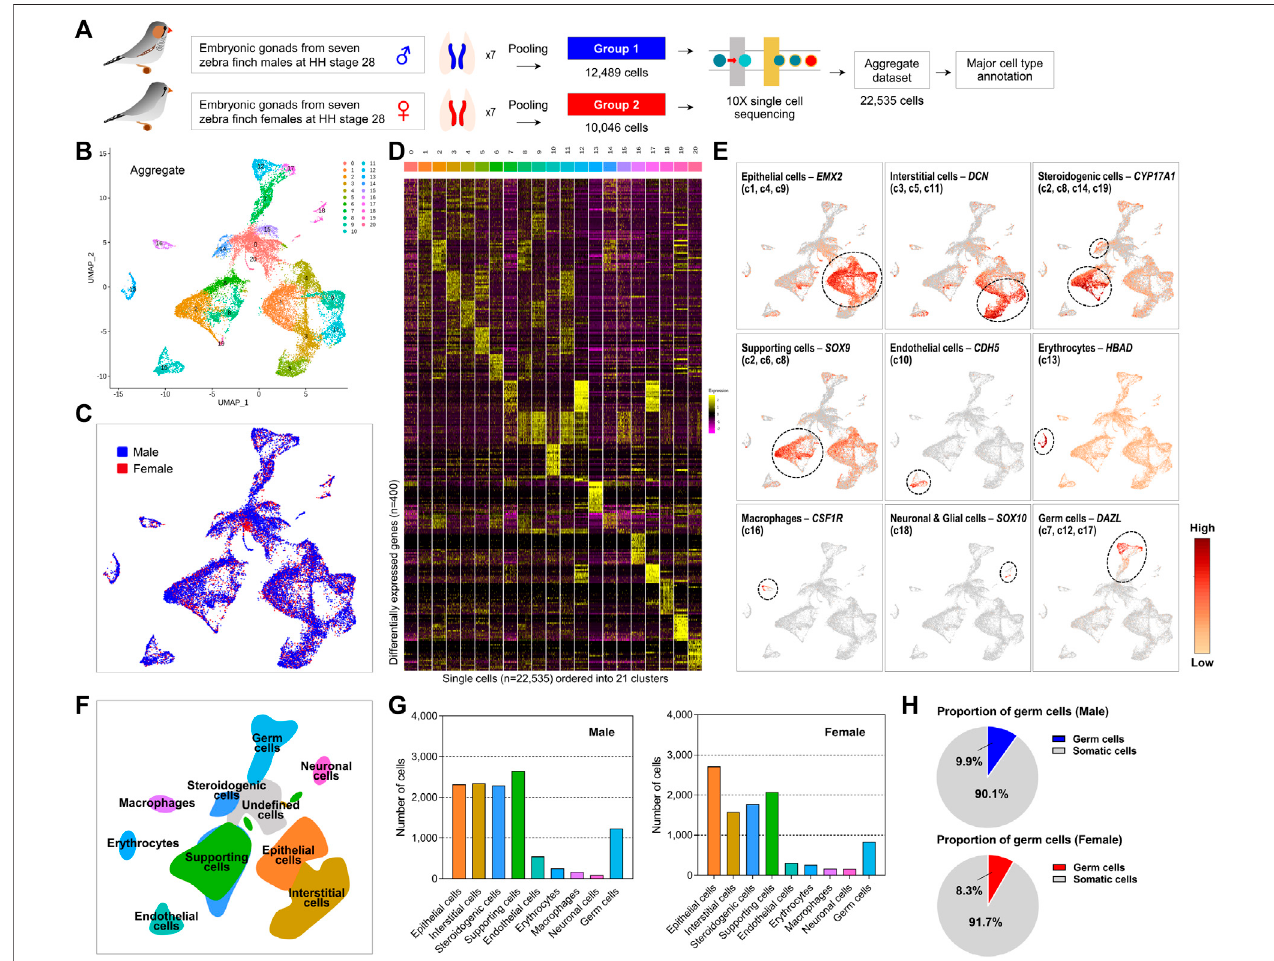
FIGURE 1 | Distinct gonadal cell subpopulations with transcriptional signatures determined by scRNA-seq analysis of zebra fi nch gonads. (A) Schematic processing of dispersed cells from male and female embryonic gonads for single-cell capture and RNA sequencing. (B) Aggregated UMAP (Uniform Manifold Approximation and Projection) clustering of all 22,535 cells (12,489 male cells and 10,046 female cells) identi fi ed 20 distinct clusters. (C) Aggregated UMAP for both sexes show high overlap between the clusters. (D) Heatmap of top 20 differentially expressed genes (DEGs) between 20 clusters of zebra fi nch gonadal cells. (E) UMAPs showing expression levels of germ cell and somatic cell marker genes. (F) UMAP-based illustration showing nine gonadal cell types. (G) Cell counts for nine different cell types. (H) Proportion of germ cells in the male and female gonadal cells.